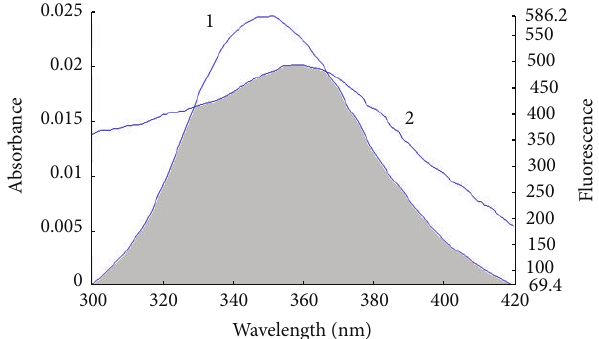
Figure7: Overlap of fluorescenceemissionspectrumof HSA(curve 1) and UV absorption spectrum of Hyp (curve 2); 𝐶 ( 1 × 10 −6 M. The distance ( 𝑟 ) was 1.95 nm from